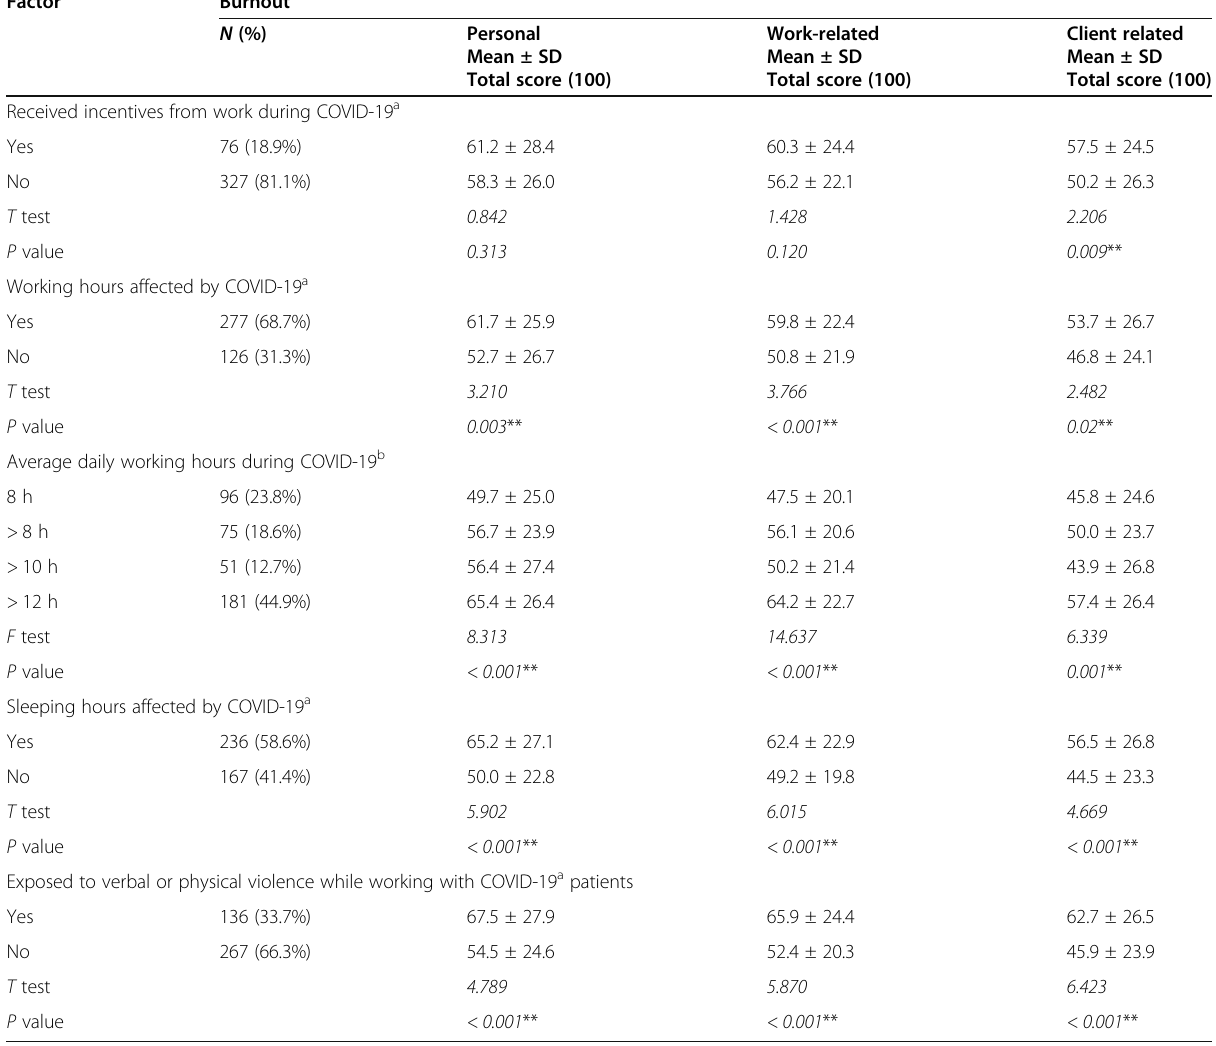
Table 4 Respondents ’ experiences during the COVID-19 pandemic ( n = 403) and statistical associations between the CBI subscales (Continued)